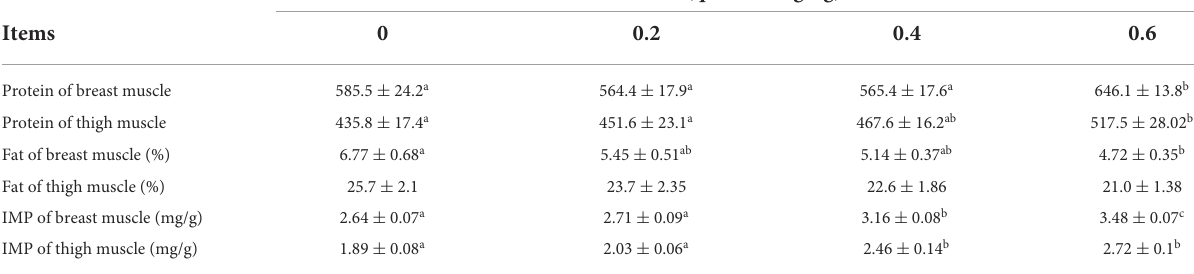
TABLE 4 Effects of dietary quercetin on the chemical composition of meat in AA